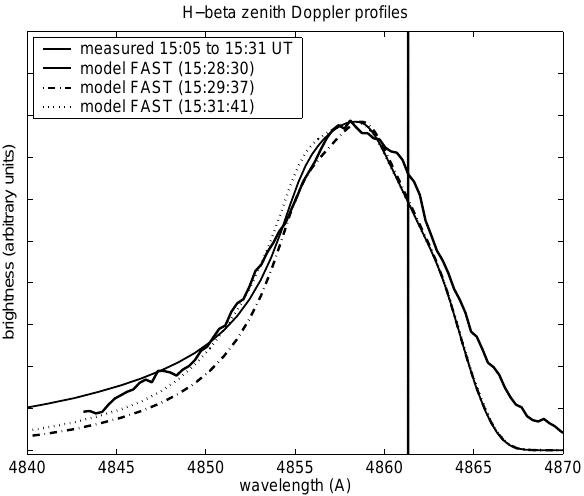
Fig. 13. Integrated H β profiles at time of increased intensity be- tween 15:05 UT and 15:31 UT. The same model profiles shown in Fig. 12 are included.